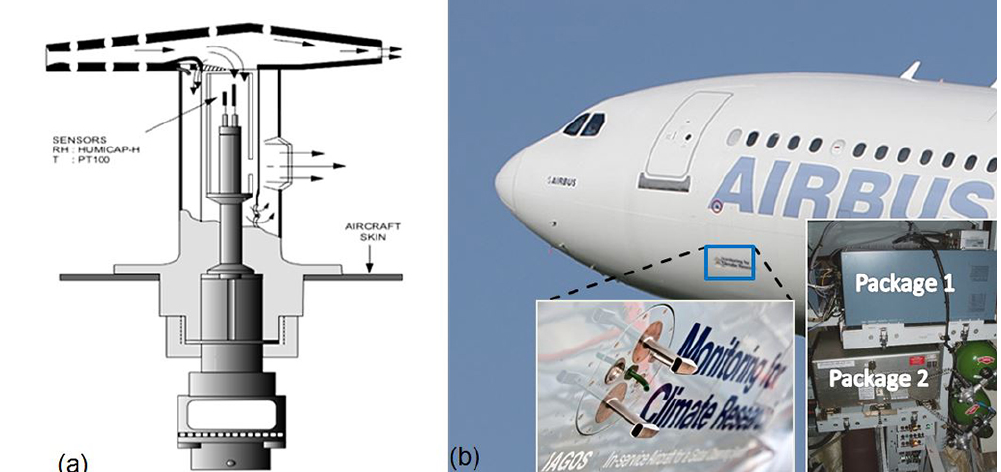
Figure 1. (a) Schematic of the temperature sensor attached to the humidity sensor mounted in the Rosemount housing (Helten et al., 1998). (b) Packages 1 and 2 installed aboard the Airbus A340-300, and the inlet plate including the Rosemount housing (photograph courtesy of